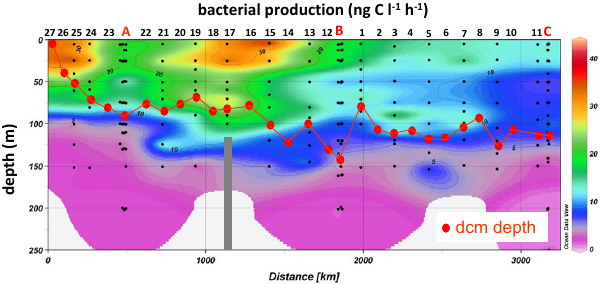
Fig. 3. Contour plot of bacterial production along the BOUM tran- sect, from the most Northwestern station (left) to the most Eastern station (right) and for the 0–250m layer. Depth of the deep chloro- phyll maximum (dcm) is also indicated (red dots). The bar at St 7 in the Sicily strait shows the bottom depth